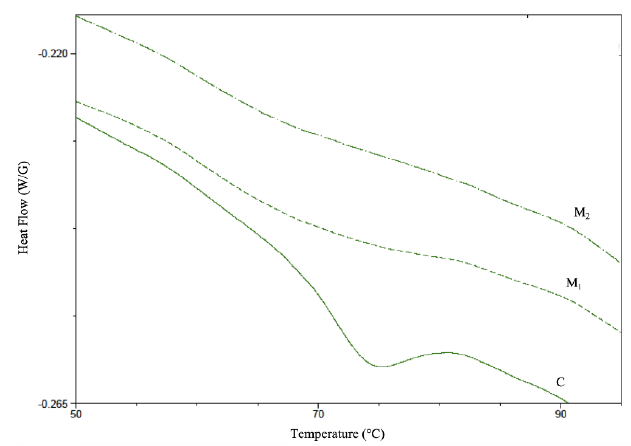
Figure 1. Di ff erential Scanning Calorimetry (DSC) representative thermograms in the 50–95 ◦ C Figure 1. Differential Scanning Calorimetry (DSC) representative thermograms in the 50 – 95 °C temperature range of the three different corn flours C, M 1 and M 2 . temperature range of the three di ff erent corn flours C, M 1 and M 2 .